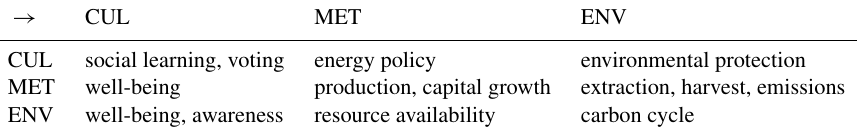
Table 1. Possible classification of exemplary model processes by owning process taxon (row) and affected process taxon (column) (fol- lowing the taxonomy developed in the companion paper Donges et al., 2018): environmental (ENV), social-metabolic (MET) and sociocul- tural (CUL).